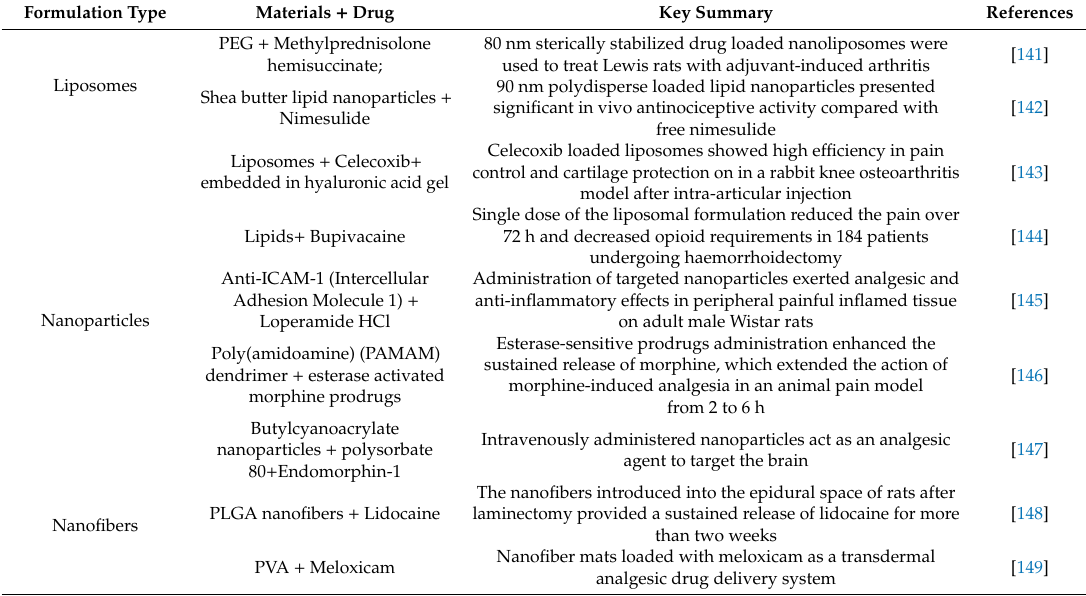
Table 7. Nanomaterials for pain